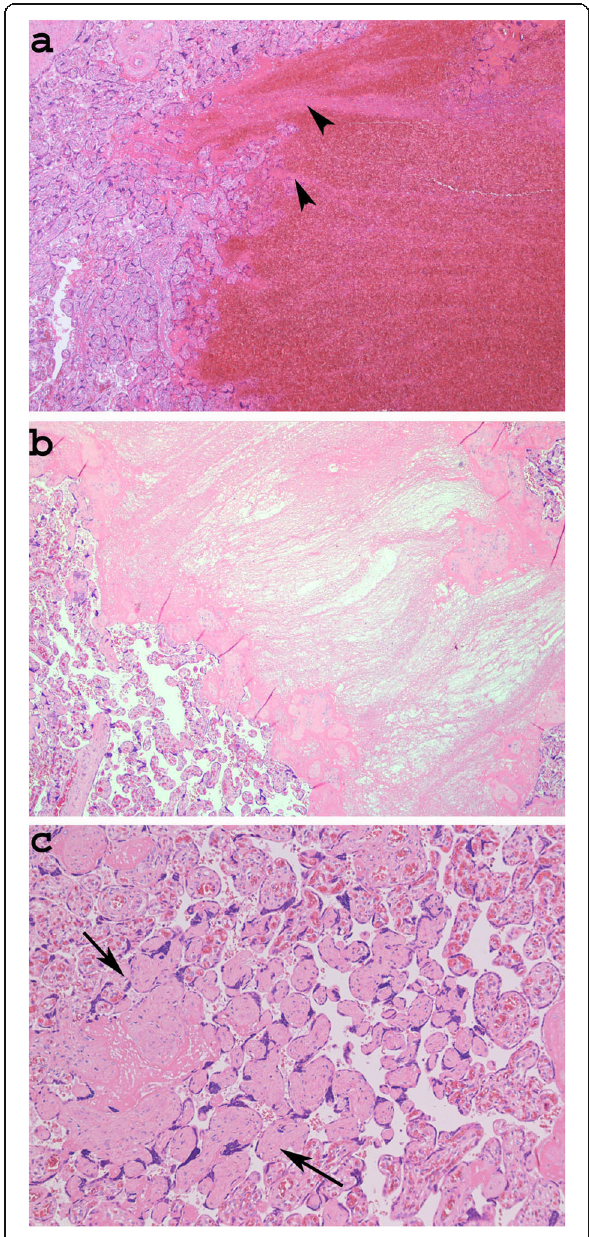
Fig. 1 Histological section of a recent thrombus showing alternating layers of red blood cells and fibrin ( a Case 5, Haematoxylin and eosin stain× 40, arrowheads: layers of fibrin). Note the absence of chorionic villi, which are displaced to the periphery. An old thrombus with uniform granular eosinophilic appearance ( b haematoxylin and eosin stain × 40). Avascular villi with eosinophilic pauci-cellular stroma ( c Case 5, haematoxylin and eosin stain × 100, Arrows: Avascular